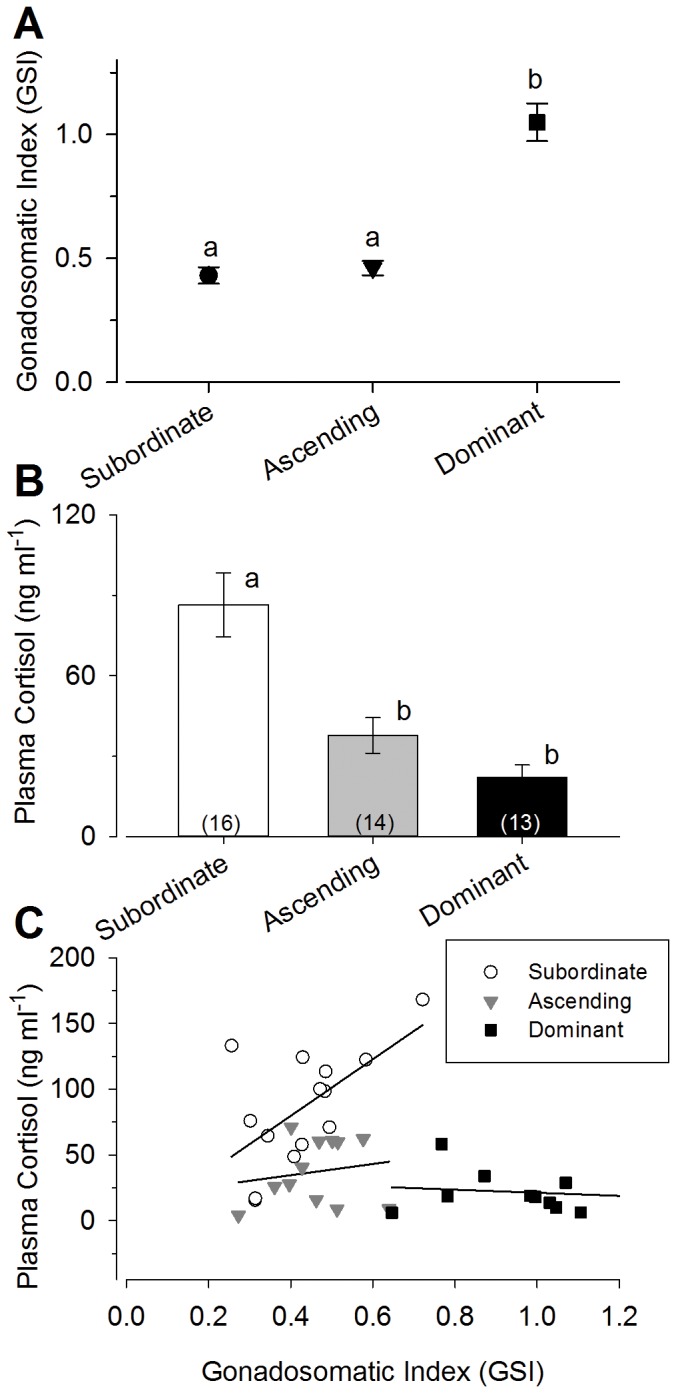
Gonadosomatic index and plasma cortisol levels differed among subordinate, ascending, and dominant male social groups.
A) Dominant males (N = 13) had higher gonadosomatic index values (GSI) compared to both subordinate (N = 16) and ascending (N = 14) males. B) Plasma cortisol levels were higher in subordinate males compared to both dominant males and males ascending in status 15 minutes after presentation of a social opportunity. Data are plotted as mean ± SEM and sample sizes are indicated in parentheses. Different letters indicate significant differences at P<0.05. C) Plasma cortisol levels were positively correlated with GSI in subordinate males (open circles), but not in ascending (grey inverted triangles) or dominant (closed squares) males.